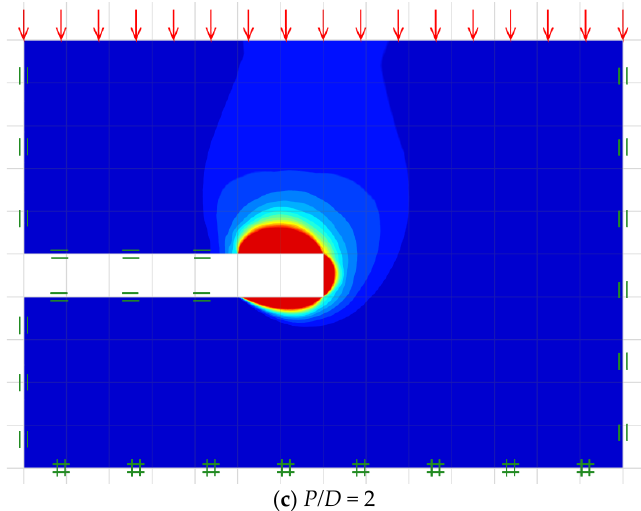
Figure 4. Typical absolute velocity contours of tunnel headings in rock masses ( C/D = 5, γD/σ ci = 0.01, GSI = 40, and m i = 30).